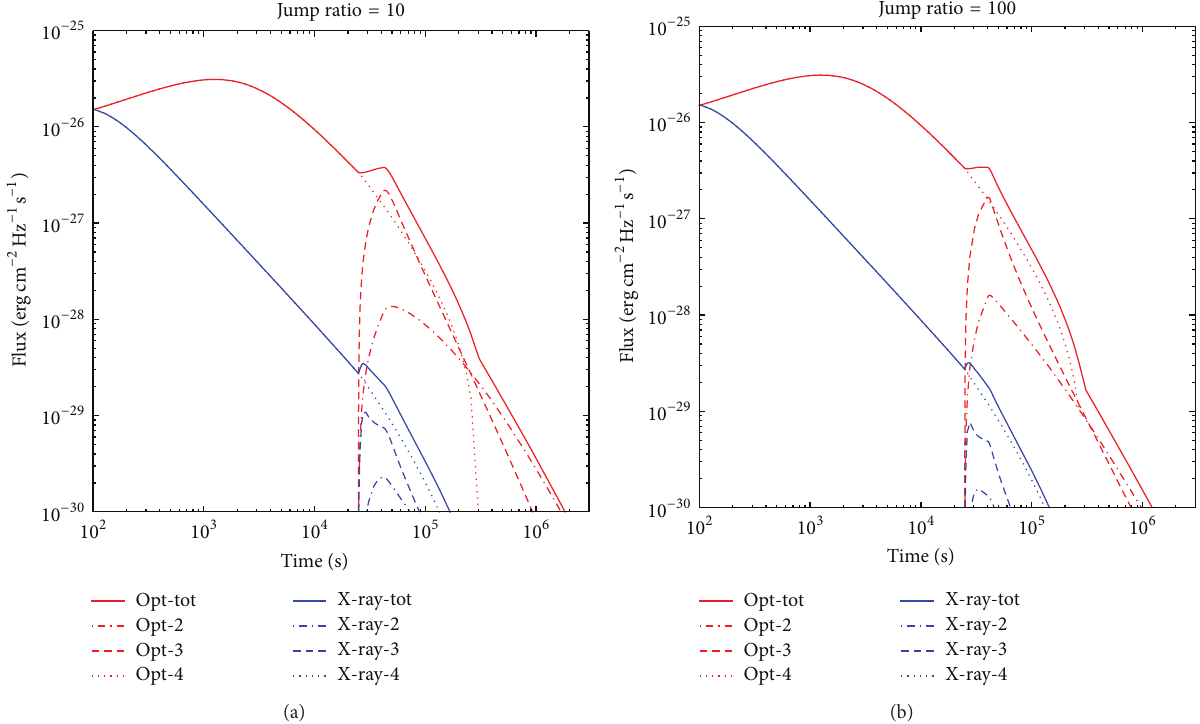
Figure 2: Corresponding afterglow lightcurves for the two cases in Figure 1. The red, blue lines are lightcurves in the optical band ( 4×10 14 Hz) and the X-ray band (0.3 keV), respectively. The dotted lines (Opt-4 or X-ray-4) represent the flux density of Region 2 before the density jump and the flux density of Region 4 after the jump. The dashed lines (Opt-3 or X-ray-3) are the contribution from Region 3 after the density jump. The dash-dotted lines (Opt-2 or X-ray-2) mark the flux density of Region 2 after the jump. Total flux densities of all the components are presented by the solid lines (Opt-tot or X-ray-tot). For a similar plot, see